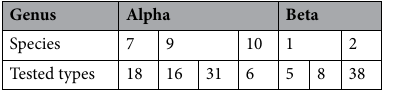
Table 1. Tested E6 proteins of different HPV